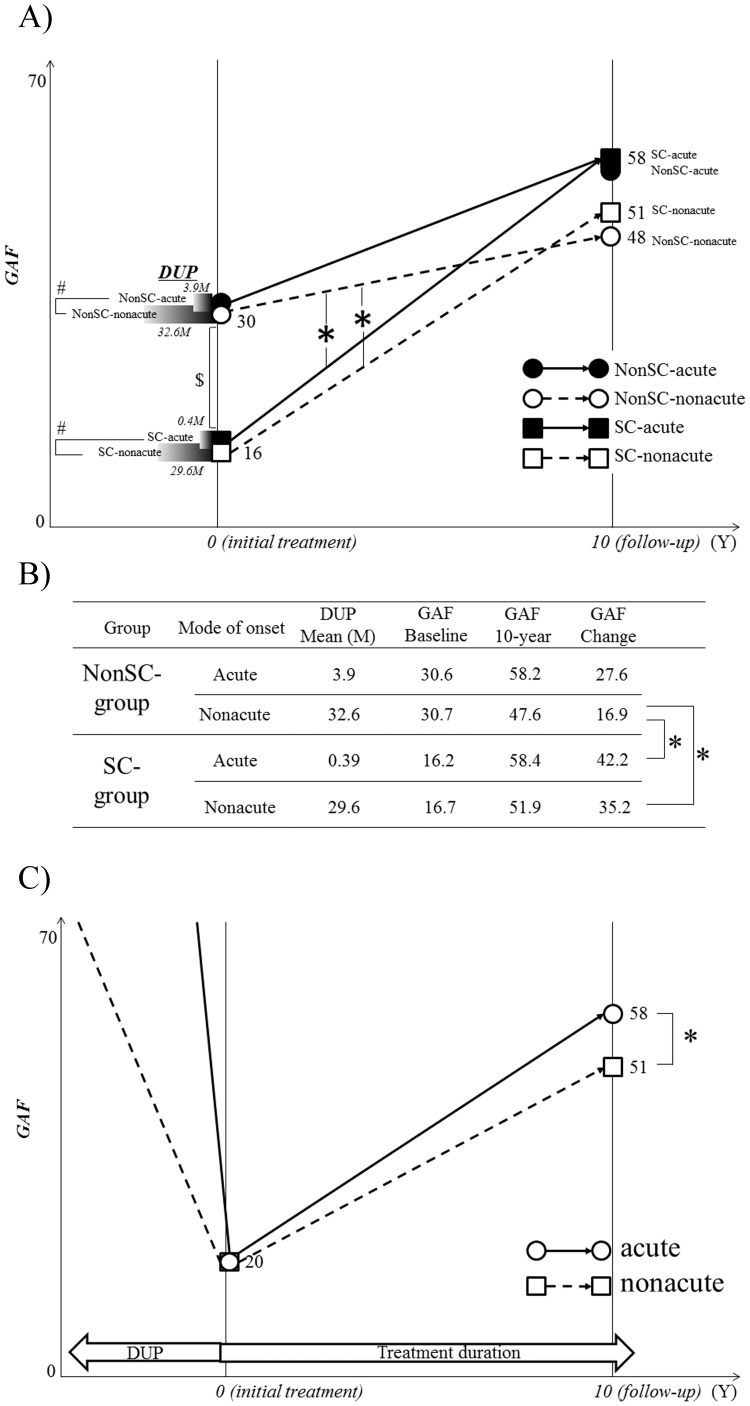
Change in the GAF from treatment intervention to 10-year follow-up point in the 4 subgroups.A)*P<.05 by ANCOVA, indicating lesser increase of GAF in the NonSC-nonacute-group than those in the SC-acute and SC-nonacute groups. # P<.05, indicating significant difference in DUP between the two groups. $ P<.05 by ANOVA, indicating a lower baseline GAF in the SC group than in the NonSC group. B) This table shows the same data as A), particular for DUP and GAF changes of participants, to support understanding of the manuscript and A). *P<.05 by ANCOVA. C) Comparison in GAF changes between the acute onset and nonacute onset groups. *P<.05 by ANCOVA.